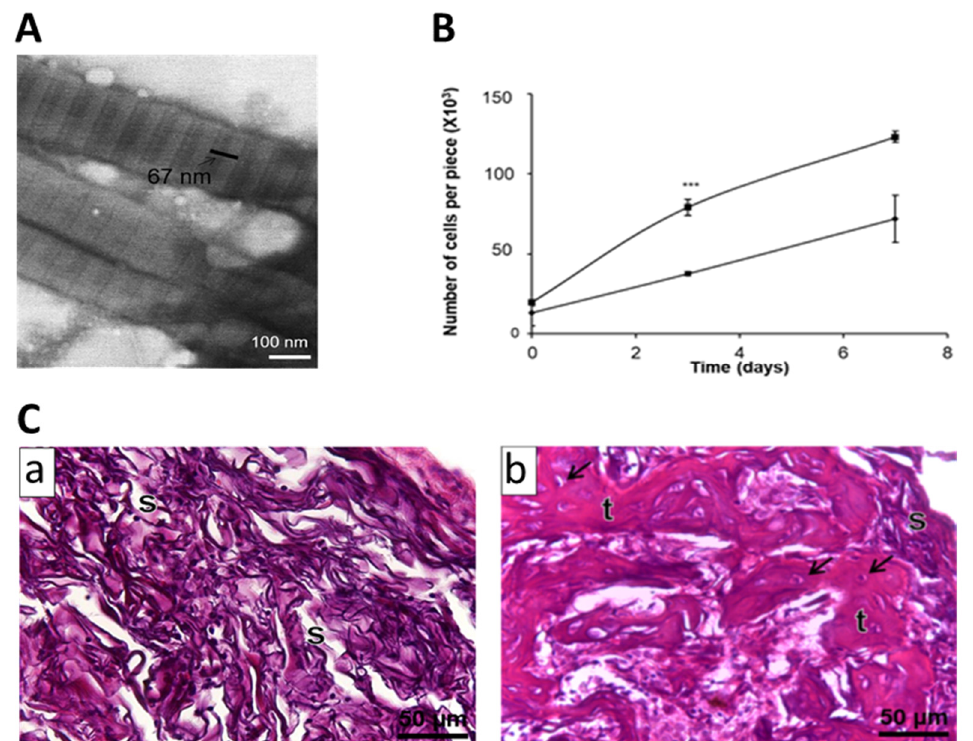
Figure 3. Characterization of a double-crosslinked atelocollagen sponge. ( A ) STEM images of negatively stained atelocollagen nanofibrils, showing an axial periodicity of 67 nm. ( B ) Adhesion and proliferation of MC3T3-E1 preosteoblasts on double-crosslinked atelocollagen sponges (DColS- 0.0015G, ) or atelocollagen sponges only crosslinked by a dehydrothermal method (DColS, ♦ ). Mean ± standard deviation. *** p < 0.001. ( C ) hematoxylin-eosin staining of histological sections of intramuscular ectopic implants. DColS ( a ) and DColS-0.0015G ( b ) sponges were loaded with 600 ng of BMP-2 and implanted for 21 days. Only the DColS-0.0015G scaffolds were able to support osteogenesis. s : collagen; t : bone trabeculae; arrows : osteocytes. Modified with permission from